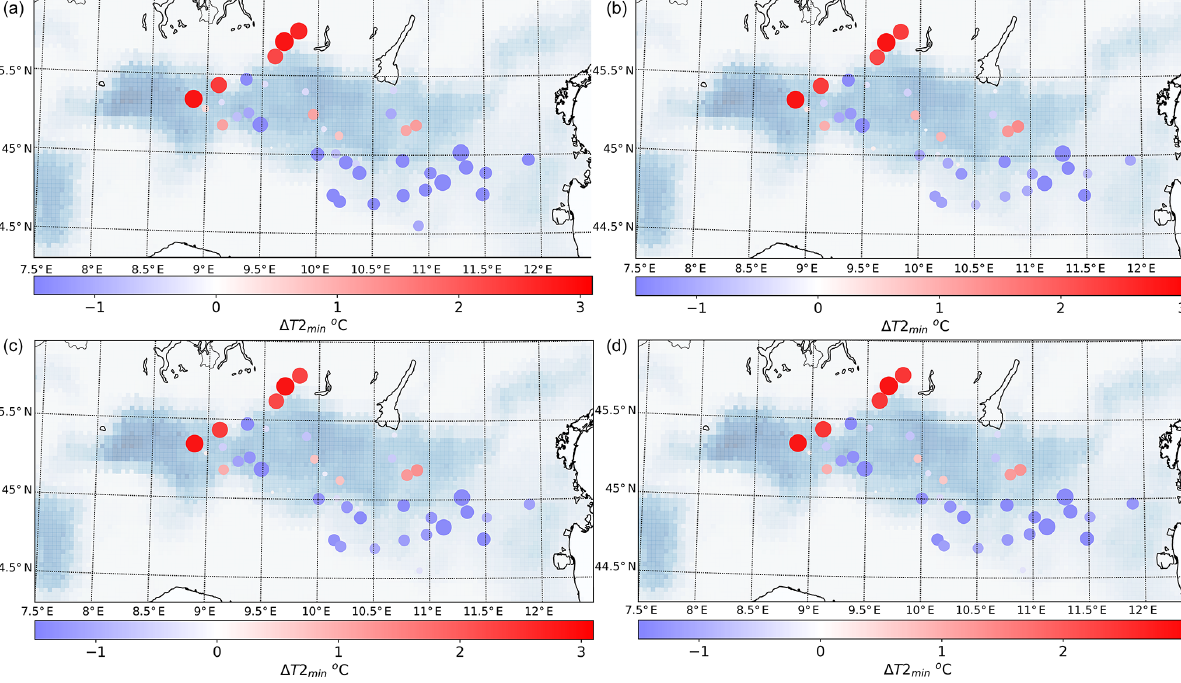
Figure 7. Monthly average for daily minimum 2m temperature difference between model run LR2 and the weather station locations for the control run (a) , CHANNEL (option 1, b ), DRlP (option 2, c ), and SPRINKLER (option 3, d